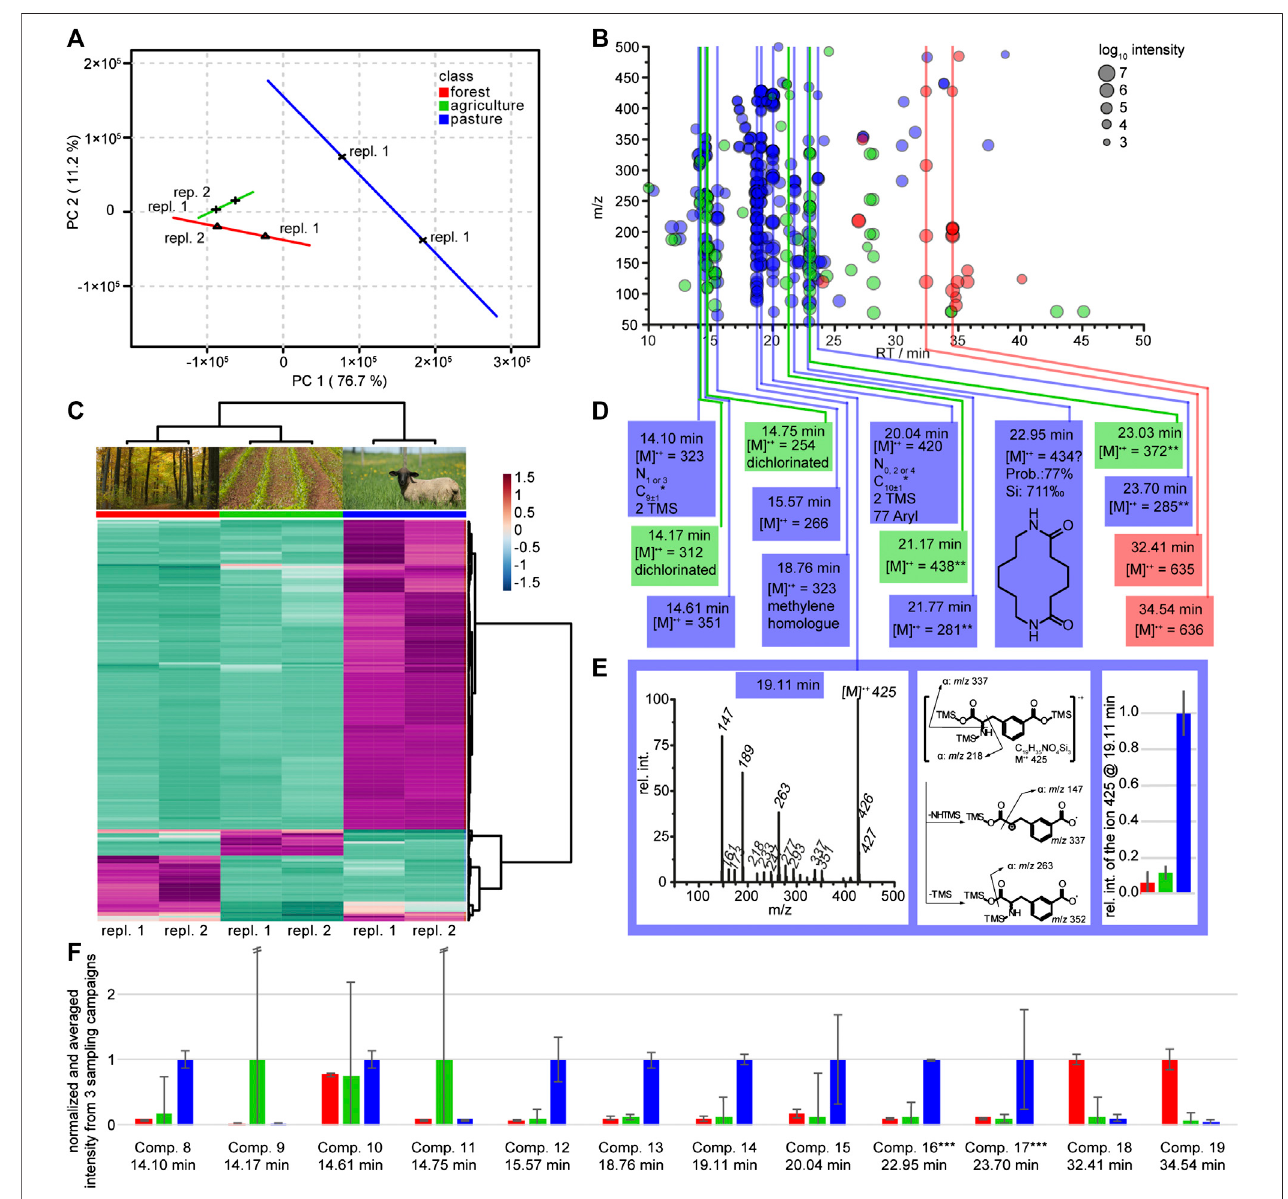
FIGURE3| Statisticalanalysisand structure elucidation ofseepagewateroriginatingfromlysimetersoftypeIII.Lysimeters wereinstalledatthreedifferentlanduse sites and data are assigned by red labels for the forest sites, green for the agricultural sites and blue for the pasture sites. (A) PCA score plot of two environmental replicates each forthedifferentlandusesites forest,agricultureand pasturebasedon GC-MS analysis. (B) Heat mapofthetop 200(ANOVA) features thatcontributeto the different land use sites. The dendrogramson top and side ofthe heatmap indicate similarity clusters ofthe sampling sites and metabolite features, respectively (environmental replicates are numbered). (C) Cloud plot of the top 200 features from the heat map in Figure part B. The color indicates land use and the cloud size the intensity in the mass spectrum. Features that appear at the same retention time are labeled with vertical lines. The most probable chemical identity of these marked featureclasses issummarizedinpart (D) . (E) Massspectrum and suggestedfragmentation mechanismofthemarkerforpasture at19.11 min(3-caboxyphenylalanine). Including a bar diagram of the relative concentrations ( ± SD) of the molecular ion 425 occurring in the land use sites. *Carbon number is calculated by the intensity of the [M+1] + ionunderconsiderationofpossiblesiliconisotopes.**Highestobservedionbutthelowmassisnotcompatiblewiththehighretentiontime. (F) Relativeintensities of selected compounds (compare Figure part D) monitored in three consecutive sampling campaigns (temporal replication), with environmental duplicate measurements. The graph shows averages (+/ − standard deviation) across campaigns per respective land use site, with the highest value per each compound normalized to one. Error bars calculated from the SD by the propagation of error. The compound marked with ** in Figure part D was excluded from the analysis. ***These compounds could only be detected in one of three sampling campaigns ( Figure part A – D ).